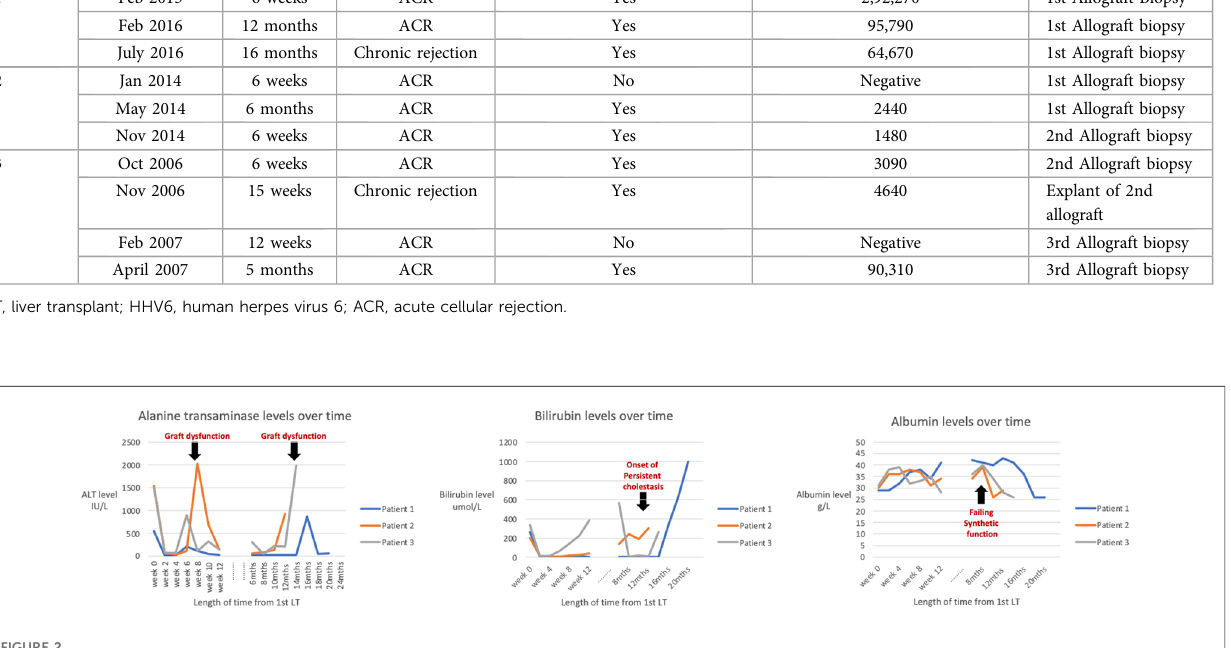
TABLE 2 Post-humous testing of liver explants and allograft biopsies for HHV-6 DNA. Patient No.